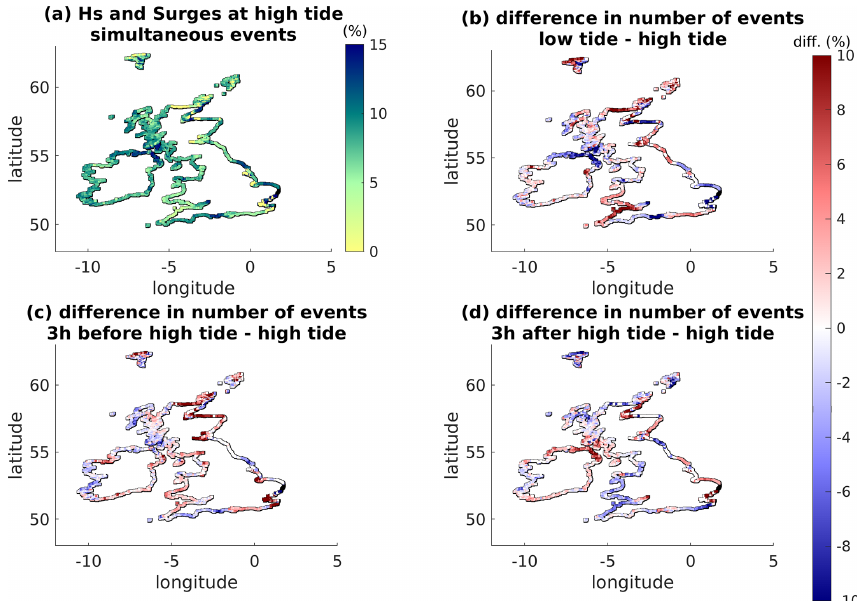
Figure 7. Number of hours in which high (above 90th percentile) H s and surge concur within 1h of high tide (a) . This number is shown as a percentage of the total number of simultaneous events recorded during the winter at each location. The plot also shows the differences between the percentage of events occurring at high tide and those occurring at low tide (b) , 3h before high tide (c) and 3h after high tide (d) . This shows how the simultaneous events are distributed over the tidal